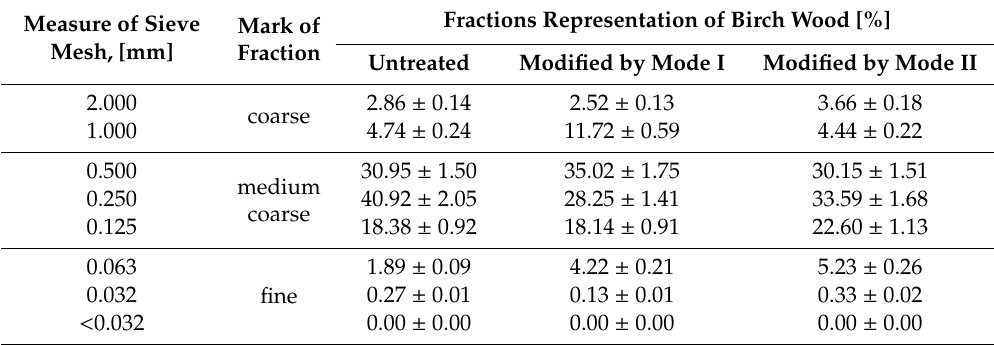
Table 5. Chips from AX320 Pinnacle, average values with standard